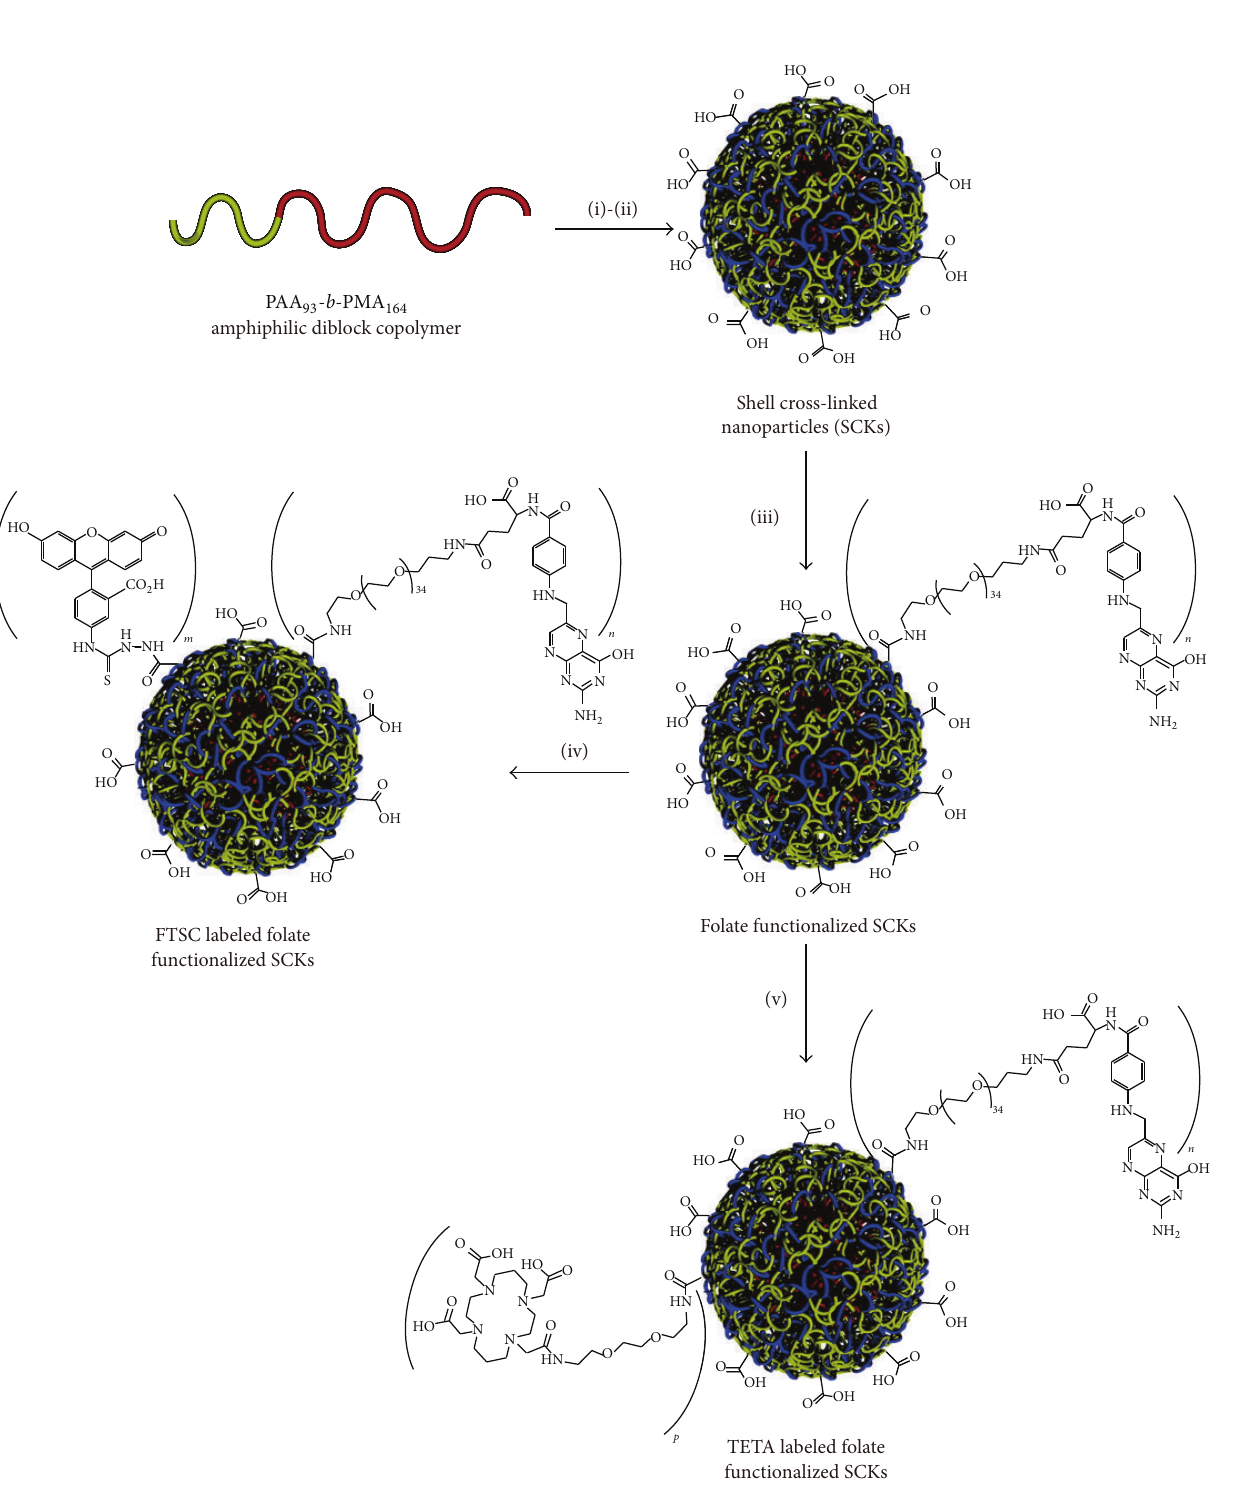
Figure 1: Polymeric micelle prepared from PMA- b -PAA. This research was originally published in JNM. R. Rossin, D. P. J. Pan, K. Qi, J. L. Turner, X. K. Sun, K. L. Wooley, and M. J. Welch. “Cu-64-labeled folate-conjugated shell cross-linked nanoparticles for tumor imaging and radiotherapy: Synthesis, radiolabeling, and biologic evaluation.” J. Nucl. Med. 2005, 46, 1210-1218. The Society of Nuclear Medicine and Molecular Imaging, Inc